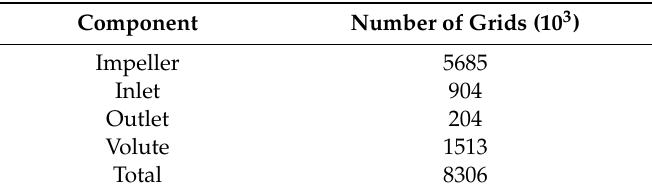
Figure 2. ( a ): The grids around the blade, ( b ): The grids around the volute tongue. Table 2. Number of grids of the computational domain.